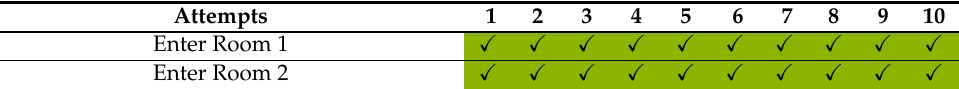
Table 8. Antennas in two rooms, table of results.